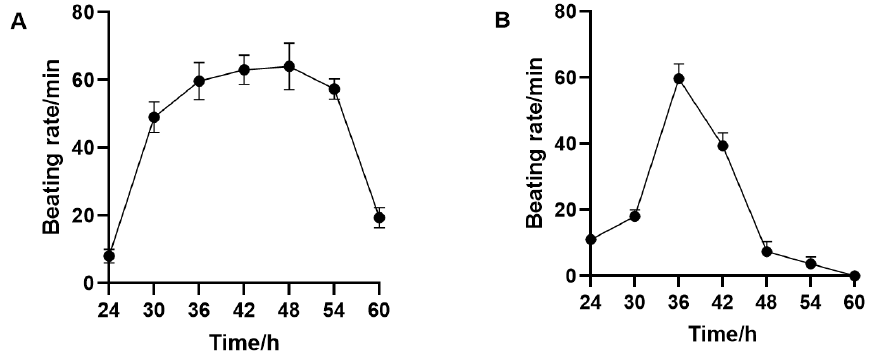
Figure 6. Statistical analysis of the multichannel cardiomyocyte beat frequency (n = 3) (( A ): QCM monitoring; ( B ): ECIs monitoring; ( B ): ECIs monitoring).